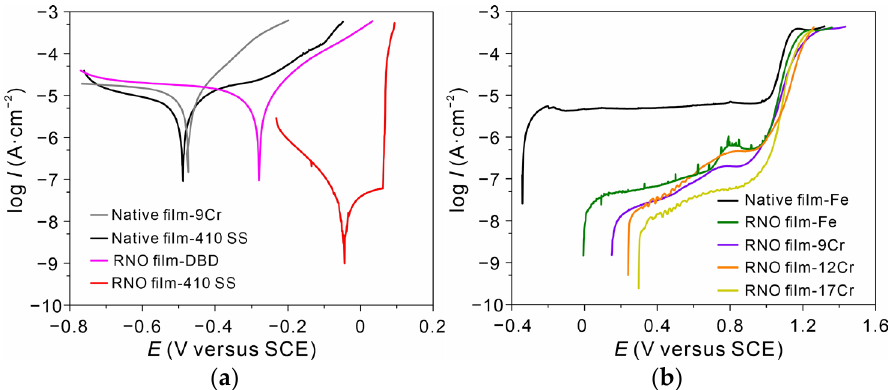
Figure 4. ( a ) Polarization curves of Fe-9Cr and 410 SS before and after 1 h of processing in 0.6 M NaCl solution (25 °C). ( b ) Anodic polarization curves of Fe-Cr alloys with varying Cr content in 0.2 M borate buffer solution (pH 7.8, 25 °C ).